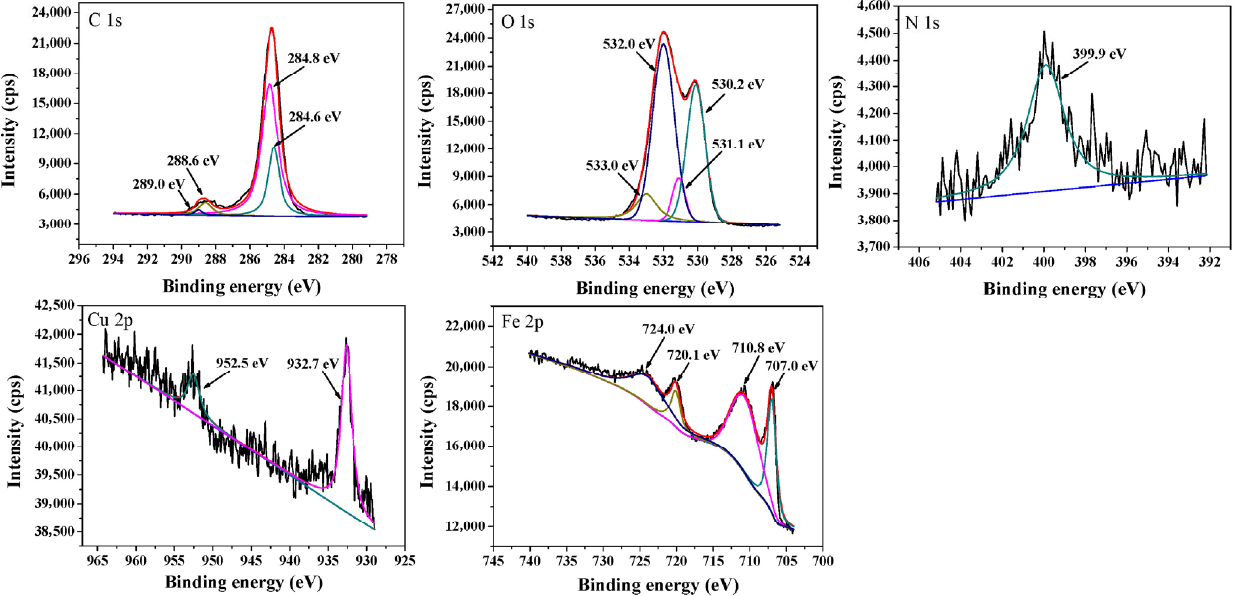
Fig. 11 XPS spectra of wear track on 304 stainless steel plate lubricated by aqueous solution of 0.8 wt% CuO nanobelts (speed: 0.02 m/s, load: 2.0 N, time: 30